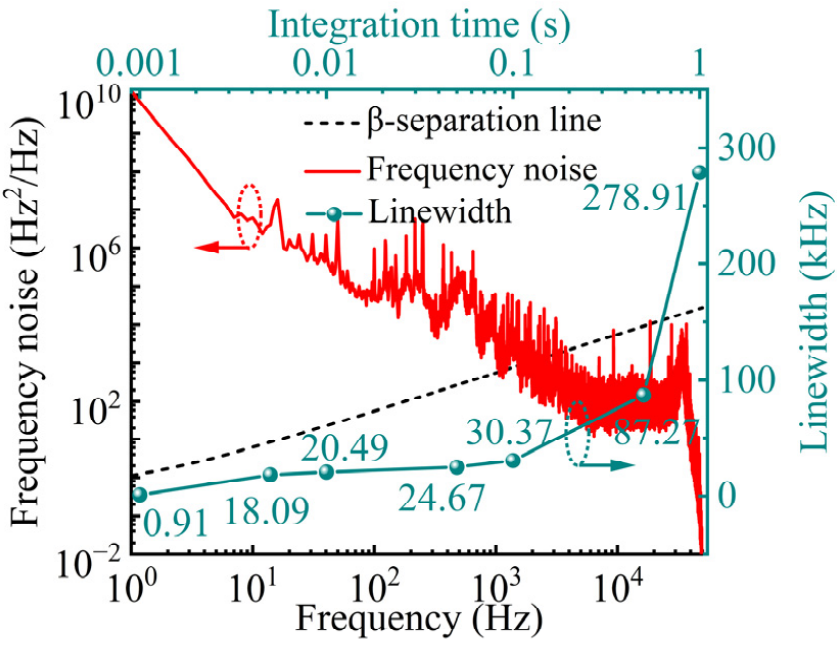
Figure 8. Frequency noise power spectral density of the proposed laser and linewidth at different integration times.